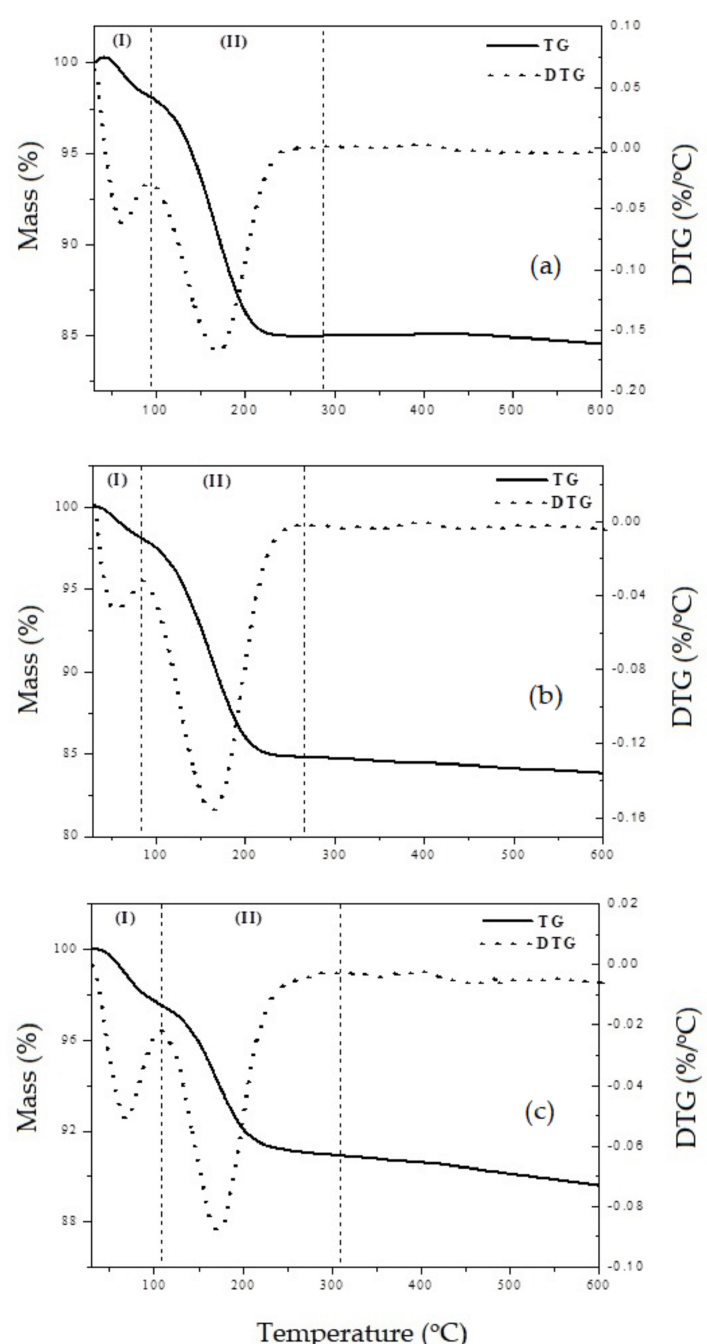
Figure 11. TG/DTG curves showing the thermal programmed desorption of n-butylamine from the adsorbed materials: ( a ) SiO 2 ; ( b ) Ce–SiO 2 and ( c ) Lu–SiO 2 .